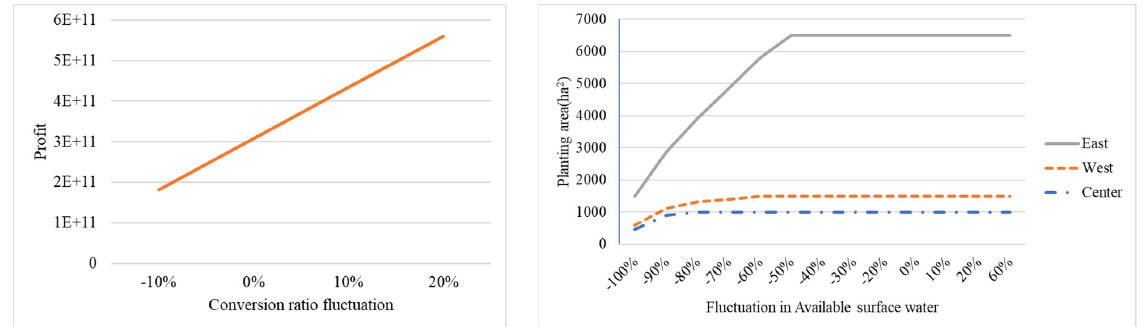
Fig. 3. Total profit vs. conversion ratio Fig. 4. Optimal planting area vs. available surface